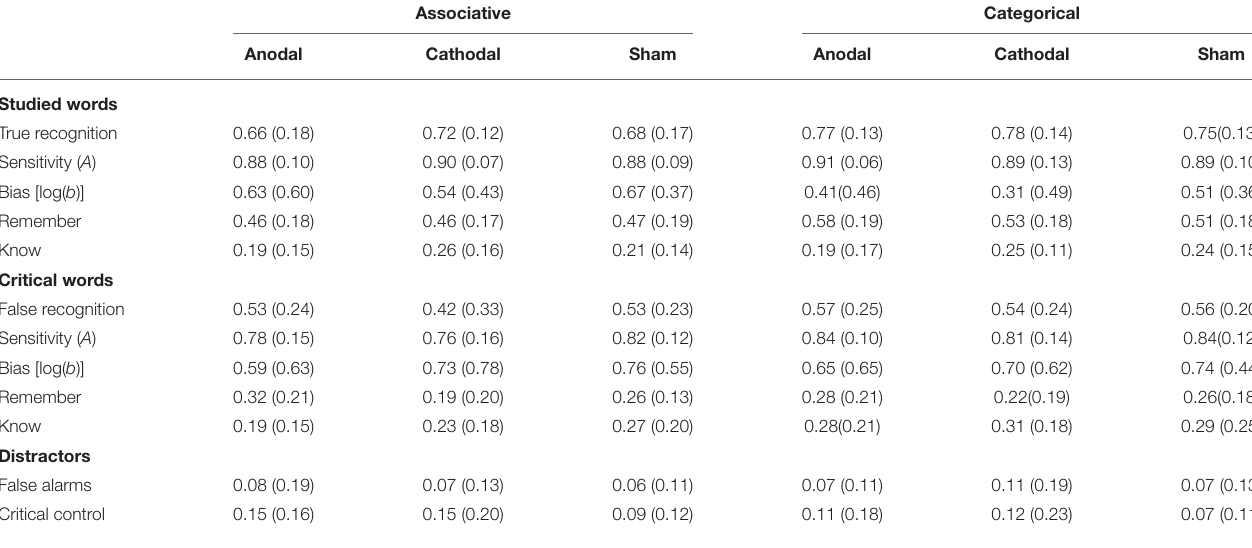
TABLE 2 | Mean recognition results (standard deviation) as a function of type of list and type of stimulation. Associative Sham Anodal